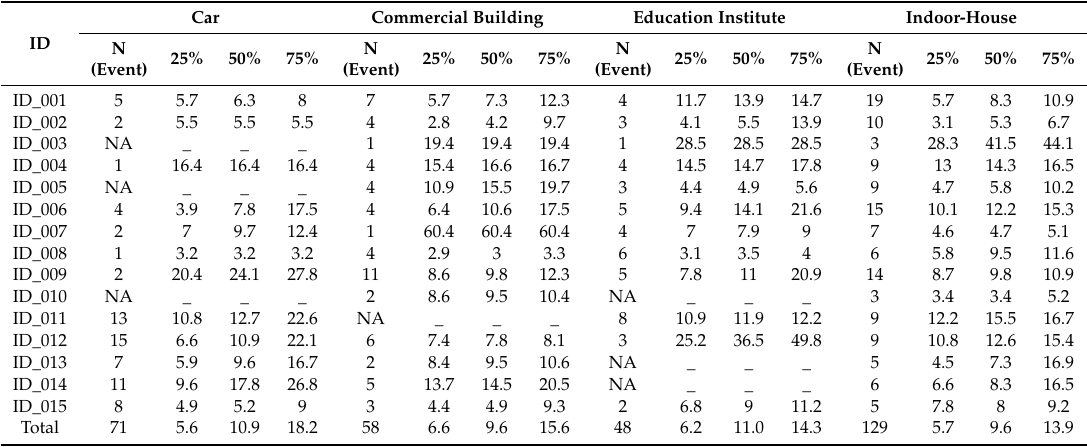
Table 3. Percentiles of PM2.5 concentration per person and